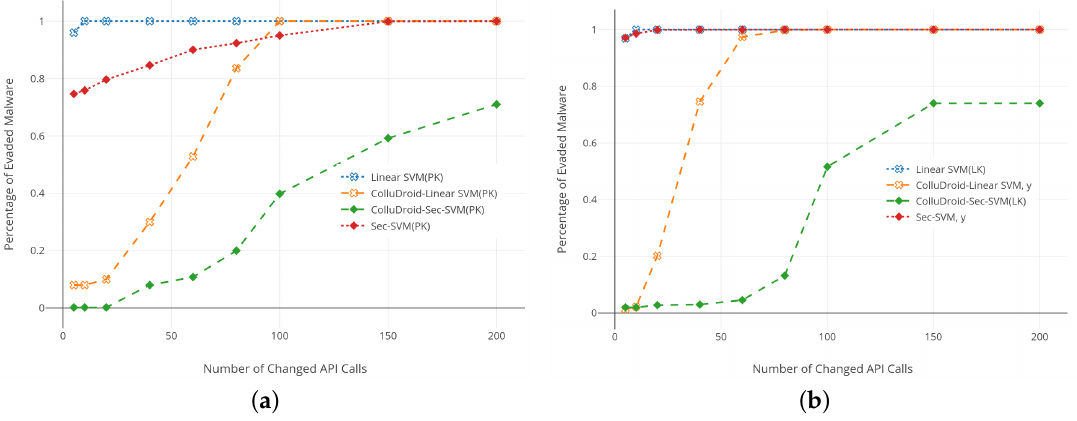
Figure 6. Performance of different methods under Collusion and Evasion attack. ( a ) perfect knowledge; ( b ) limited